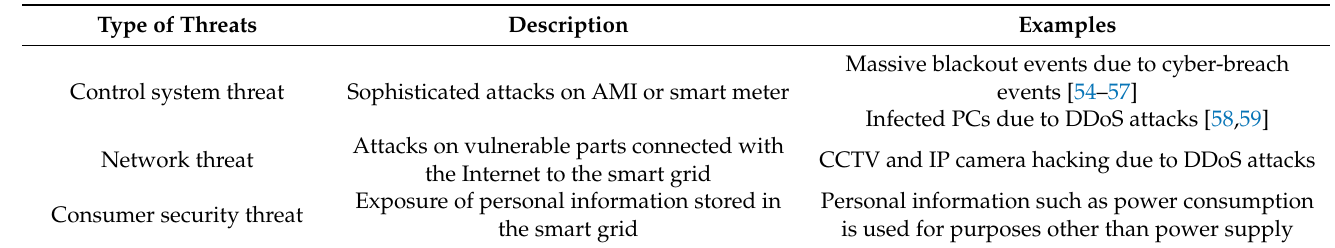
Table 2. Security threats in Smart